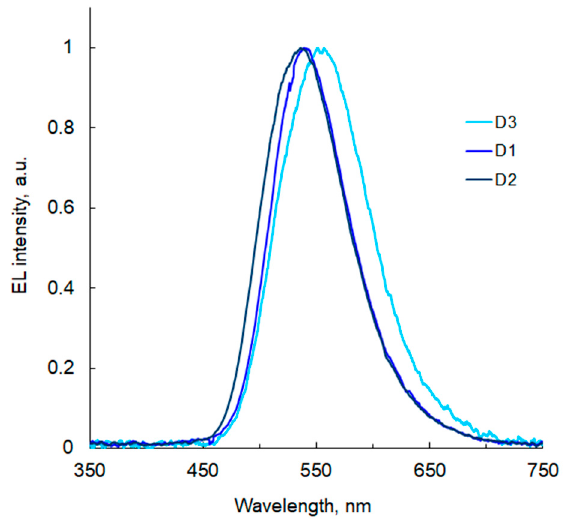
Figure 5. EL spectra of the studied OLEDs.